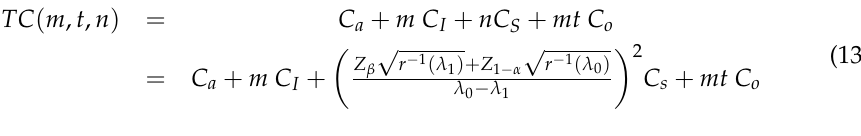
Table 4. The optimal ( m *, n *), total cost TC and critical value C 0